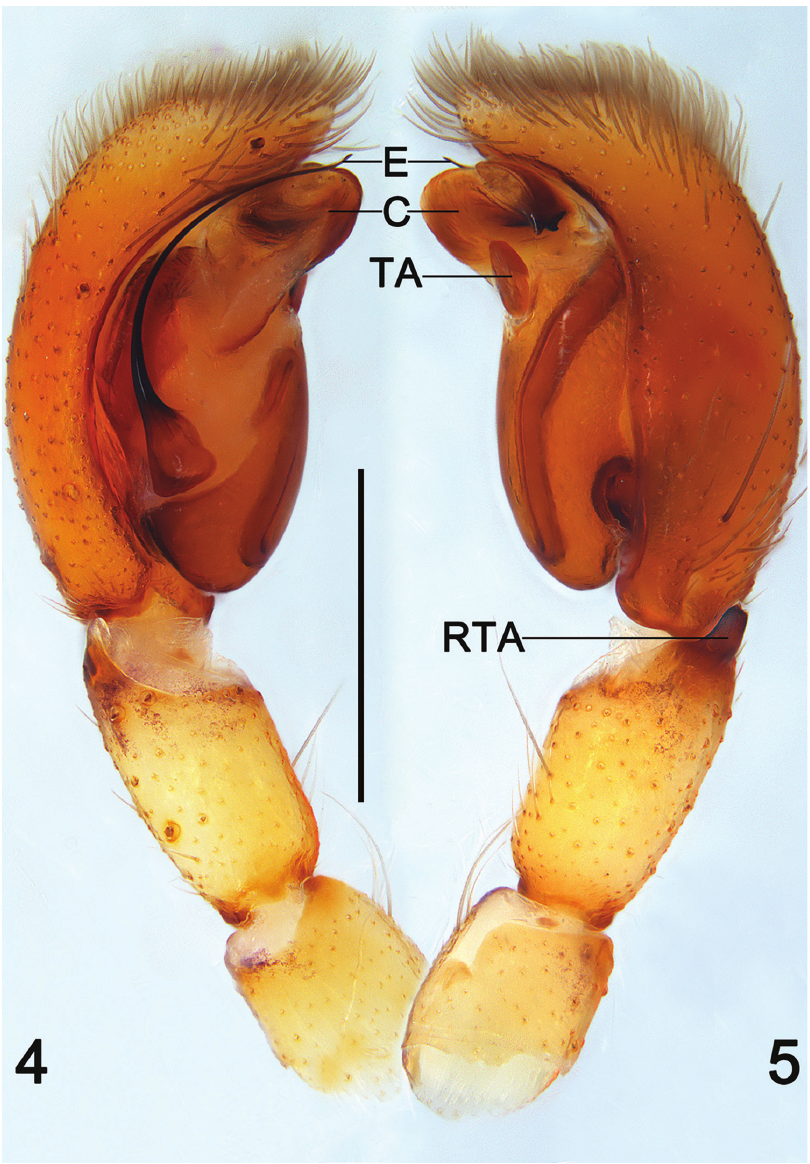
Figures 4–5. Clubiona grucollaris sp. n., male holotype. 4 left palp, prolateral view 5 same, retrolateral view. Scale bars 0.5